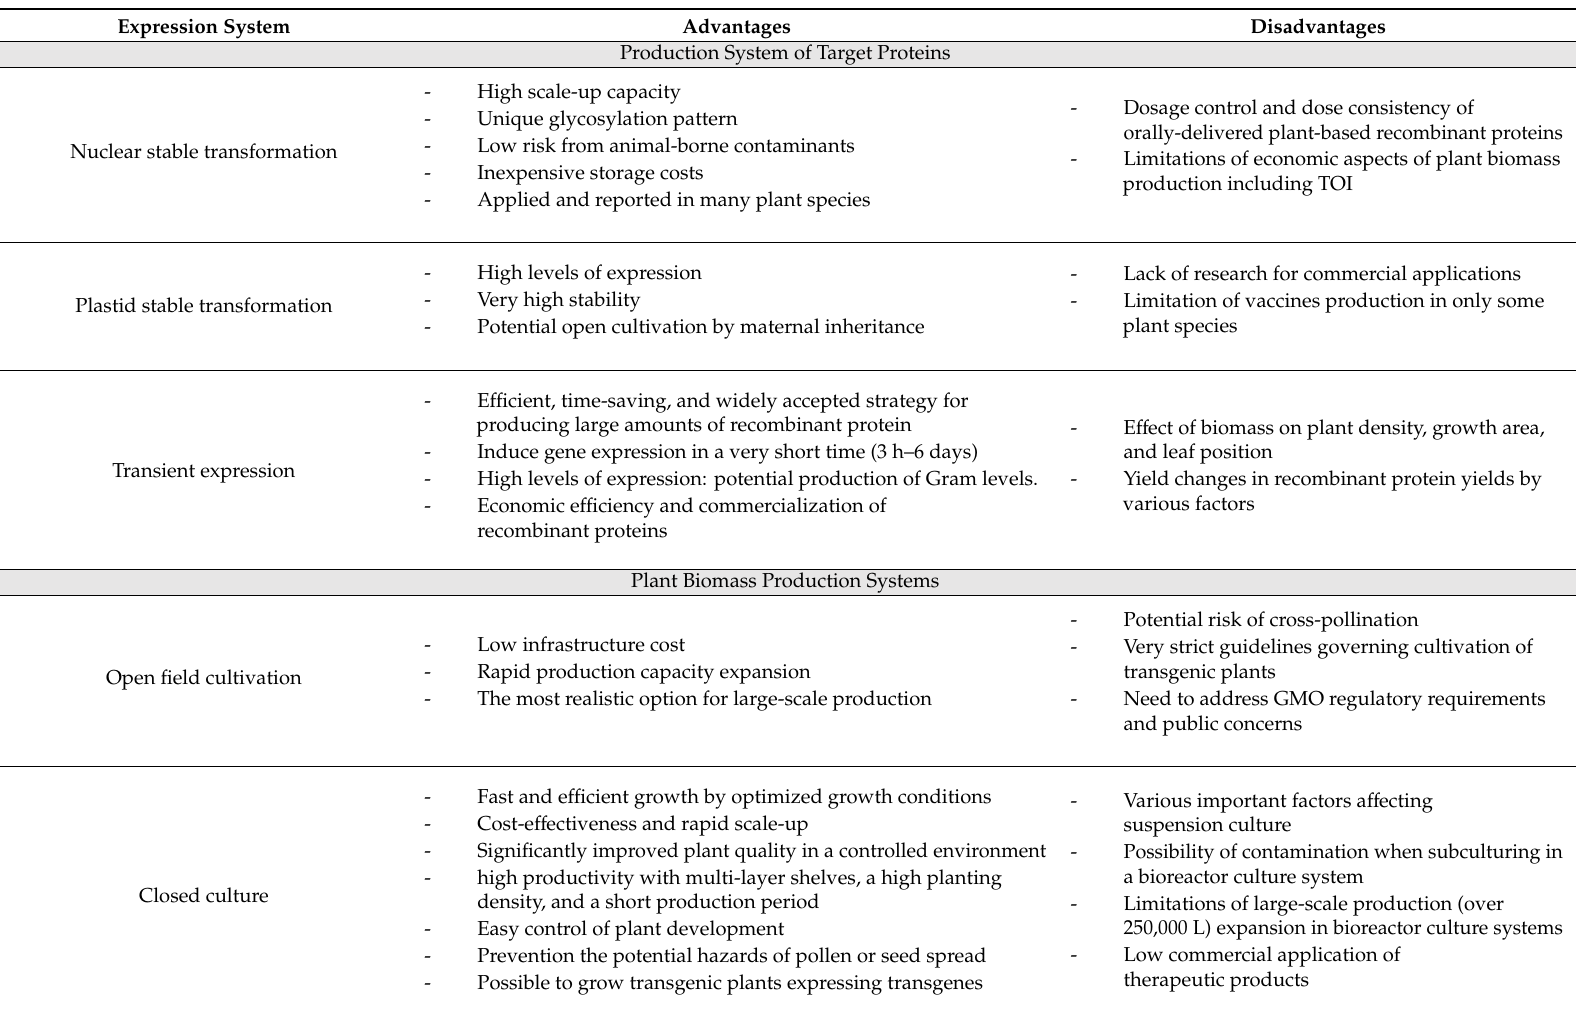
Table 1. Summarizing the advantages and disadvantages of plant expression